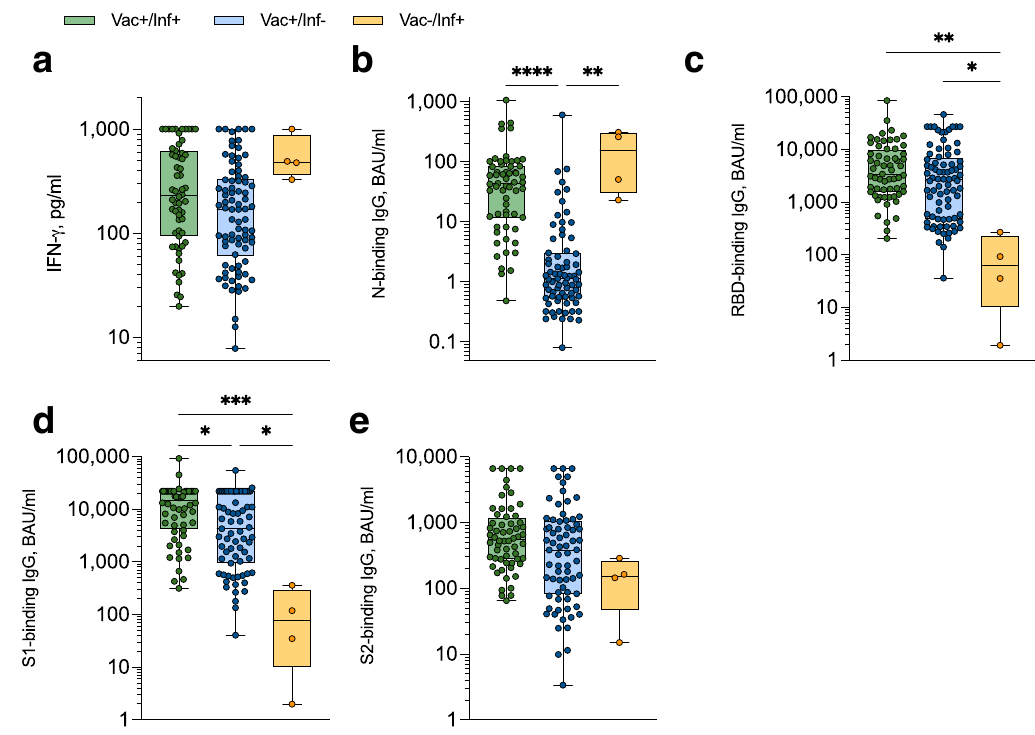
Fig. 1 | Magnitude of anti-SARS-CoV-2 T cell and IgG responses measured in venous blood samples. a SARS-CoV-2-speci fi c IFN- γ + T cell responses were mea- sured using the venous whole blood assay and sub-divided based on participant vaccination and prior SARS-CoV-2 (PCR and/or lateral fl ow test con fi rmed) infec- tion status. ‘ Vac+/Inf+ ’ n =60 (green), ‘ Vac+/Inf- ’ n =82 (blue), ‘ Vac-/Inf+ ’ n =4 (yellow), ‘ Vac-/Inf- ’ n =1 (not plotted). SARS-CoV-2-speci fi c IgG-binding responses targetingnucleocapsid( ‘ N ’ )( b ;**** P <0.0001,** P =0.0016),spikereceptorbinding domain ( ‘ RBD ’ ) ( c ; ** P =0.0022, * P <0.015), spike subunit 1 ( ‘ S1 ’ ) ( d ; *** P =0.0005, *(Vac+/Inf+vs.Vac+/Inf-) P =0.022,*(Vac-/Inf+ vs.Vac+/Inf-) P =0.012)and spike